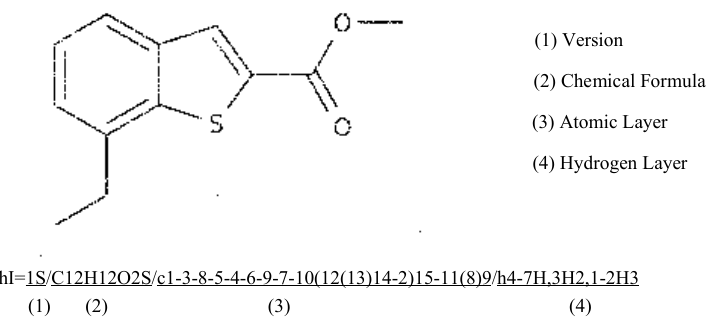
Figure 1. A glimpse of the training